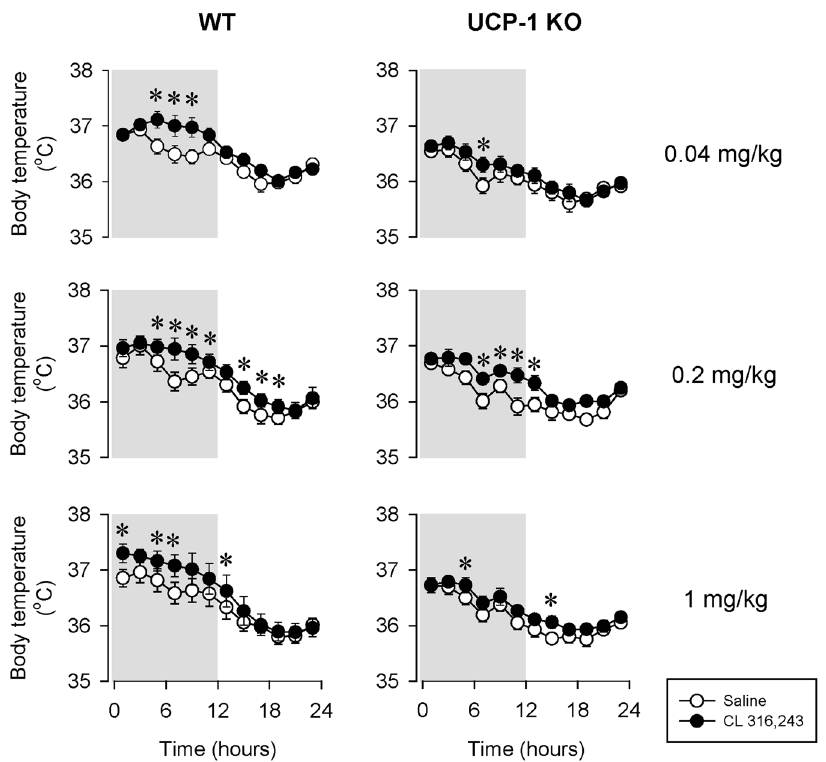
Figure 6. The effects of the selective β 3-AR agonist CL-316,243 on body temperature in WT (left panels) and UCP-1 KO (right panels) mice. See Fig. 1 for